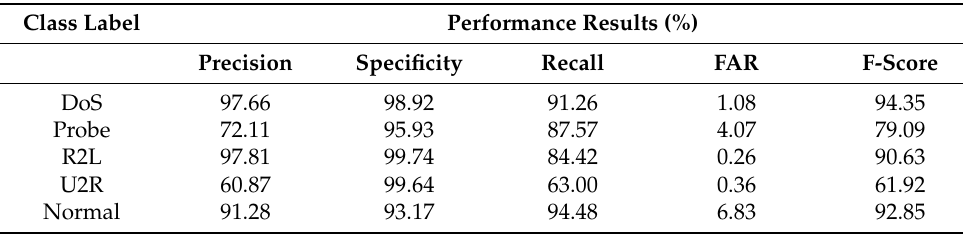
Table 14. Standard LSTM performance results on NSL-KDDTest + using 21 features.